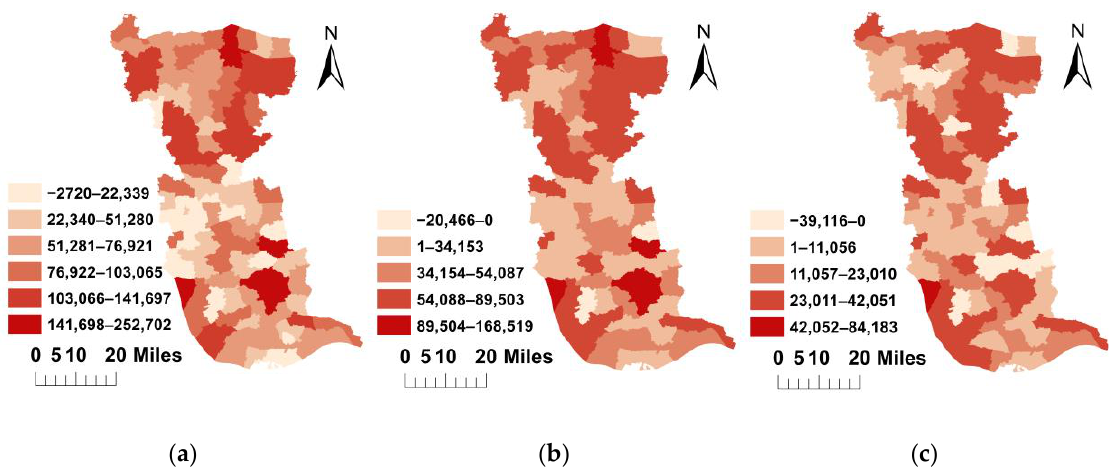
Figure 6. Livestock multiplication potential (head) calculated with different ratios of livestock manure nutrients to total nutrients of agricultural fertilizers: ( a ) 30%, ( b ) 20%, and ( c ) 10%.